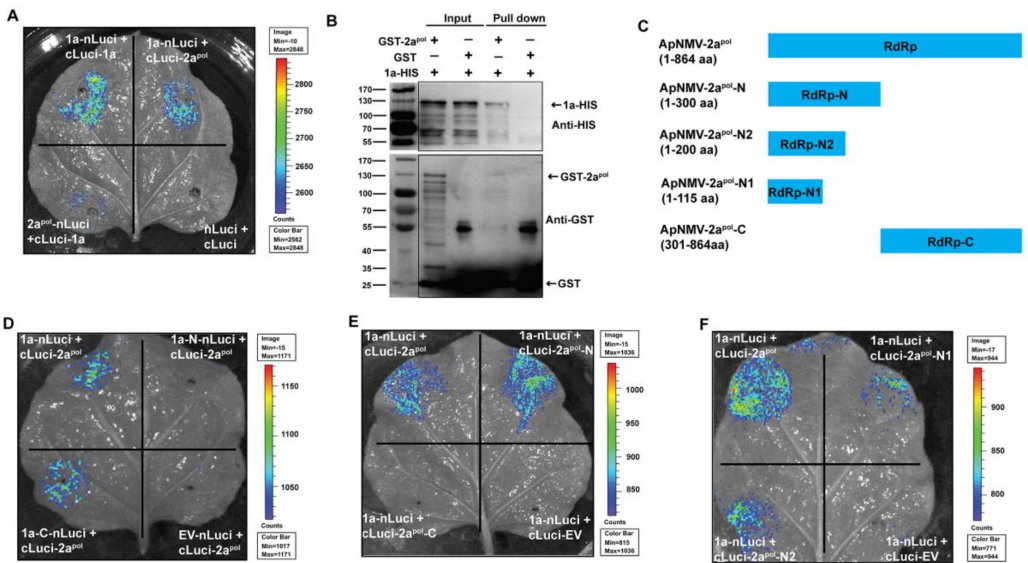
Figure 5. ApNMV 1a interacts with 2a pol . ( A ) A luciferase complementation imaging assay suggests the existence of interactions between 1a and 2a pol . ( B ) A pull-down assay demonstrates the presence of an interaction between 1a and 2a pol in vitro. GST served as the control. Molecular mass is labeled (KDa) on the left side. GST-1a, GST, and 1a-HIS bands are indicated by arrows on the right side. ( C ) Schematic model of split 2a pol that was used in the following luciferase assay. Results of luciferase complementation imaging assay in ( D – F ) identified the fragments that were responsible for the 1a–2a pol interactions. The bar on the right side indicates the intensity of signals